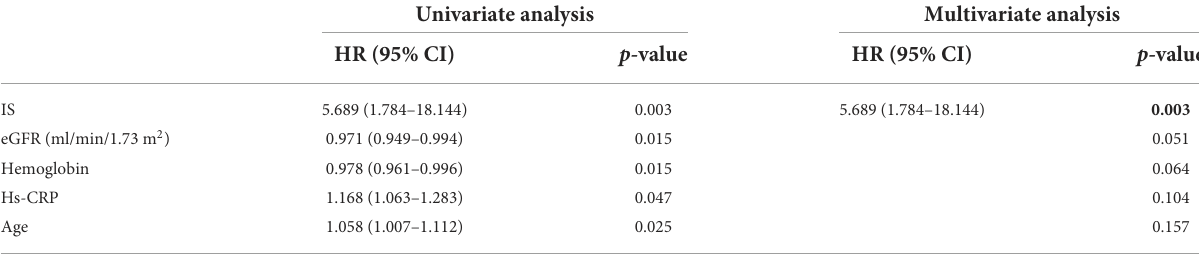
TABLE 4 Related factors of 1-year all-cause death in patients with hypertrophic cardiomyopathy ( n =